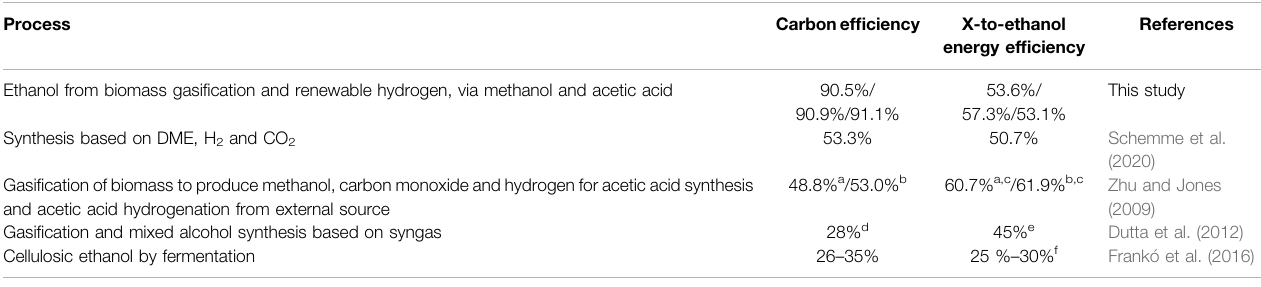
TABLE 6 | Comparison with alternative ethanol production